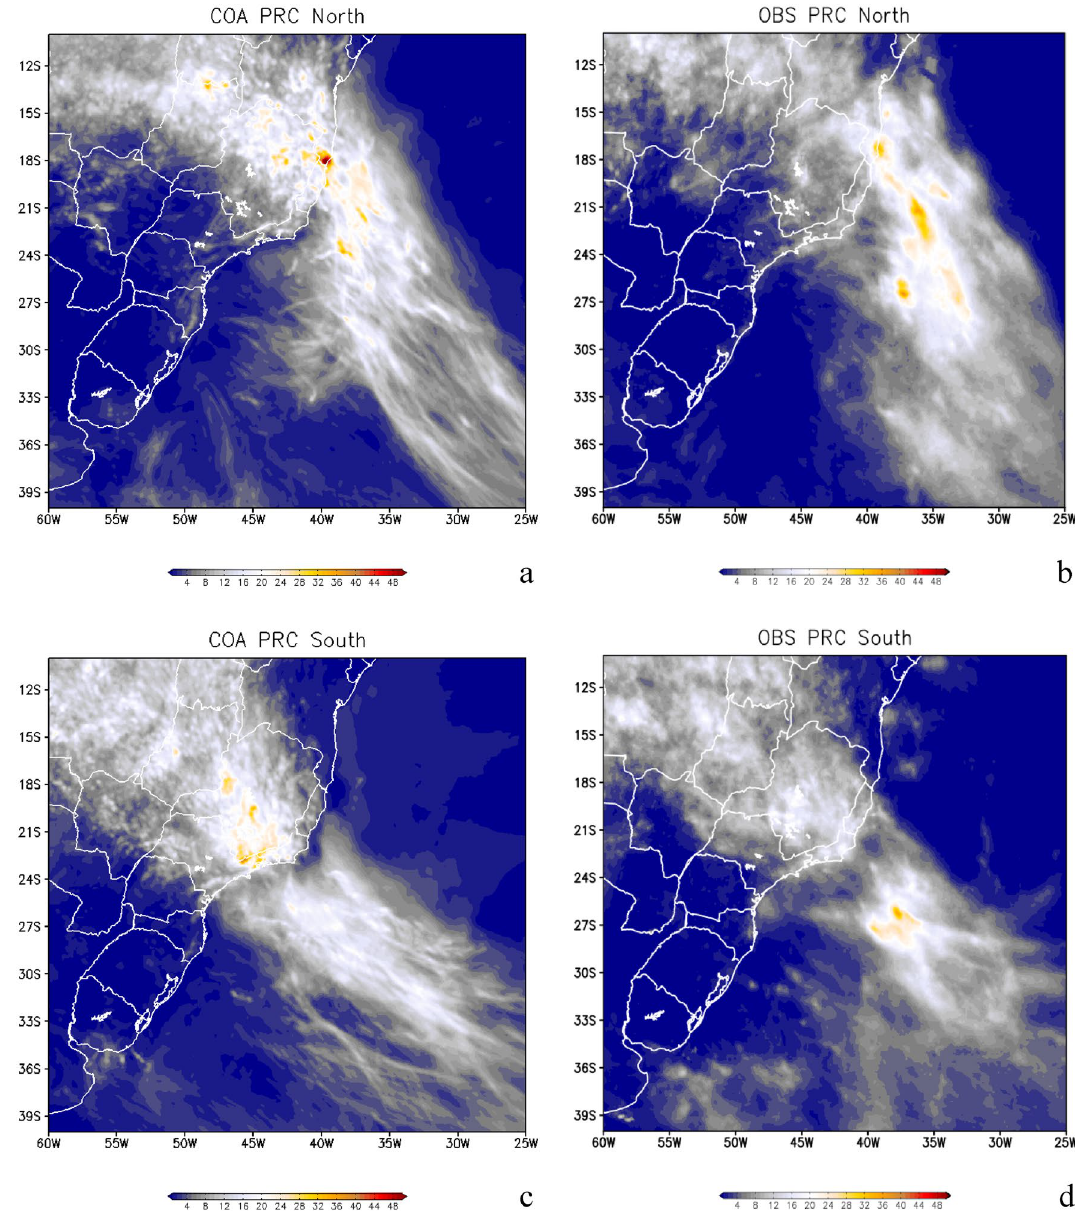
Figure 3. Simulated precipitation ( a ) and observed precipitation ( b ) for the three cases where the oceanic South Atlantic Convergence Zone (SACZ) were anchored further north. Panels ( c,d ) are for the four oceanic SACZ cases when they were anchored further south. Precipitation is in mm day −1 . Grid Analysis and Display System (GrADS), Version 2.2.1.oga.1. http:// openg rads. day −1 ) over each area indicated in Fig. 4e–g. The areas are over the continent, and over the ocean, and the total area includes both, for the oceanic SACZ cases. The PW average brings the information that the amount of water in the atmosphere in each of these areas is very large. The amount is greater in the southern cases for both regions over the continent (slightly larger) and over the ocean, which have a direct influence on the Amazon region, with 433.5 mm day −1 for the continental region and 502.5 mm day −1 for the oceanic region. As we see in regions further north, this amount is still very large, with a reduction of approximately 13.7% over the continent and 7.5% over the oceanic region, compared to the southern cases. The larger amount of PW is also found in the southern cases when the total value (in both areas marked by the red line in Fig. 4e–g is 938.8 mm day −1 as shown in Table 4.